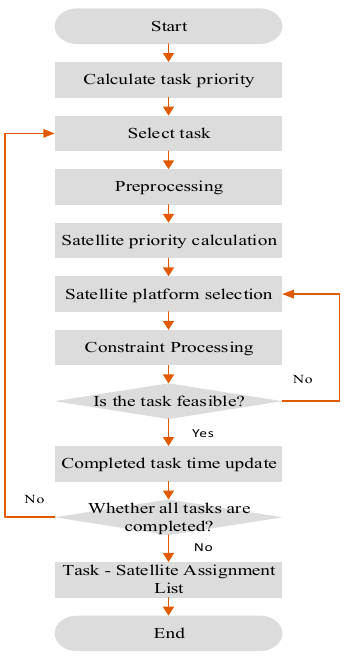
Figure 8. Constellation observation scheduling algorithm flow chart.